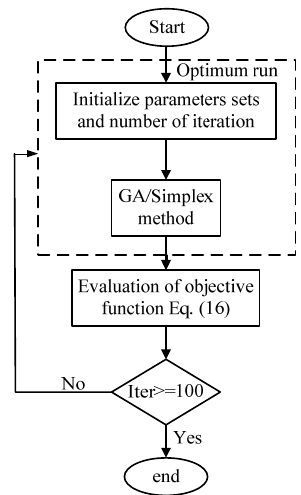
Figure 8. Generalized optimization flow using the optimum run module in PSCAD.